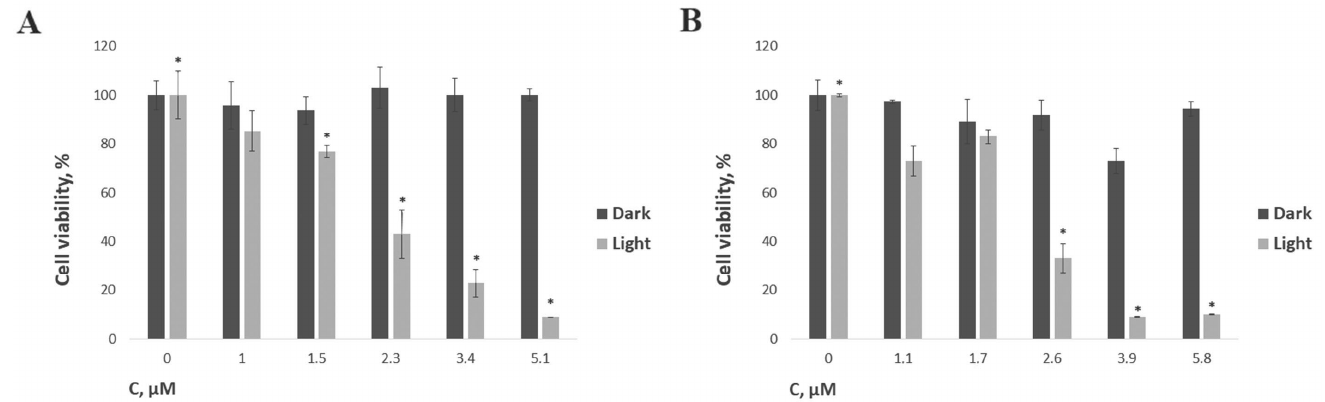
Figure 5. The effect of compounds on the viability of Hep2 cell line. Cells were irradiated for 90 min using the Medical Therapy Philips TL 20W/52 lamp (irradiation dose of 8.073 J/cm 2 ). Incubation of cells with the compound without irradiation in the dark for 90 min. * statistically significant differences in cell survival relative to the values with zero concentration of the compound ( p < 0.01) were noted. ( A ) conjugate 12 ; ( B ) conjugate 14 . Table 4. IC 50 of compounds 12 and 14 for the Hep2 and NKE cell